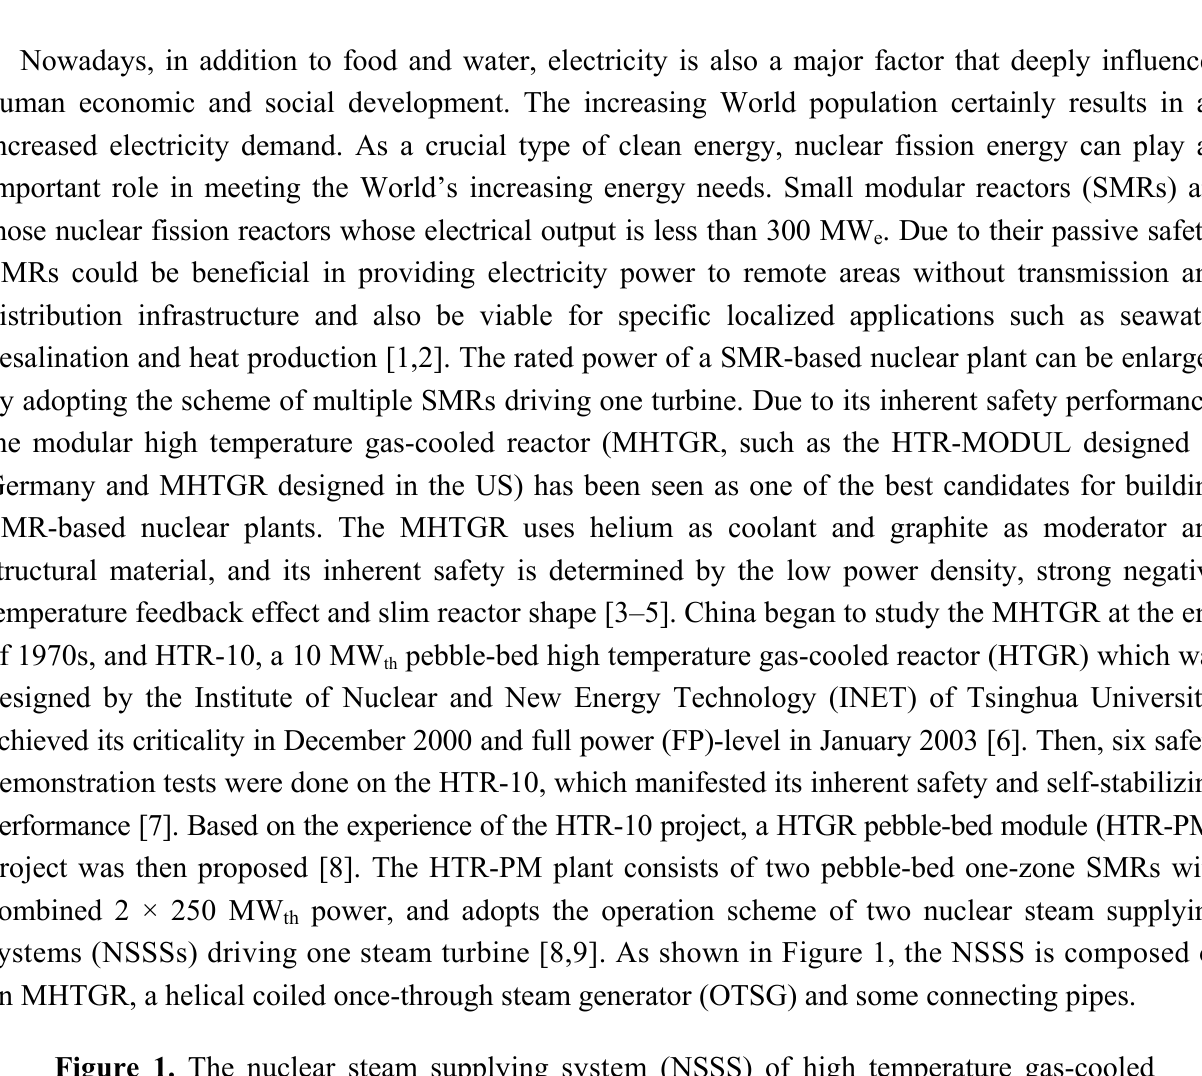
reactor pebble-bed module (HTR-PM)